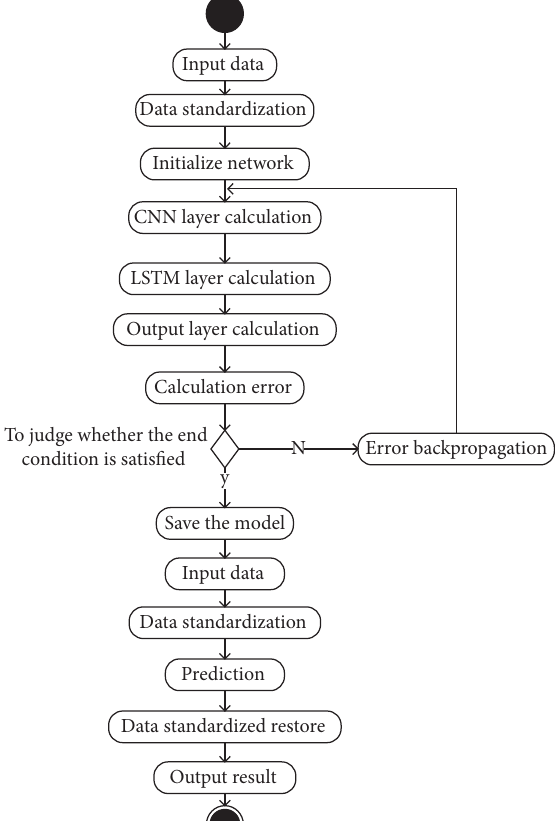
Figure 3: Activity diagram of CNN-LSTM training and prediction